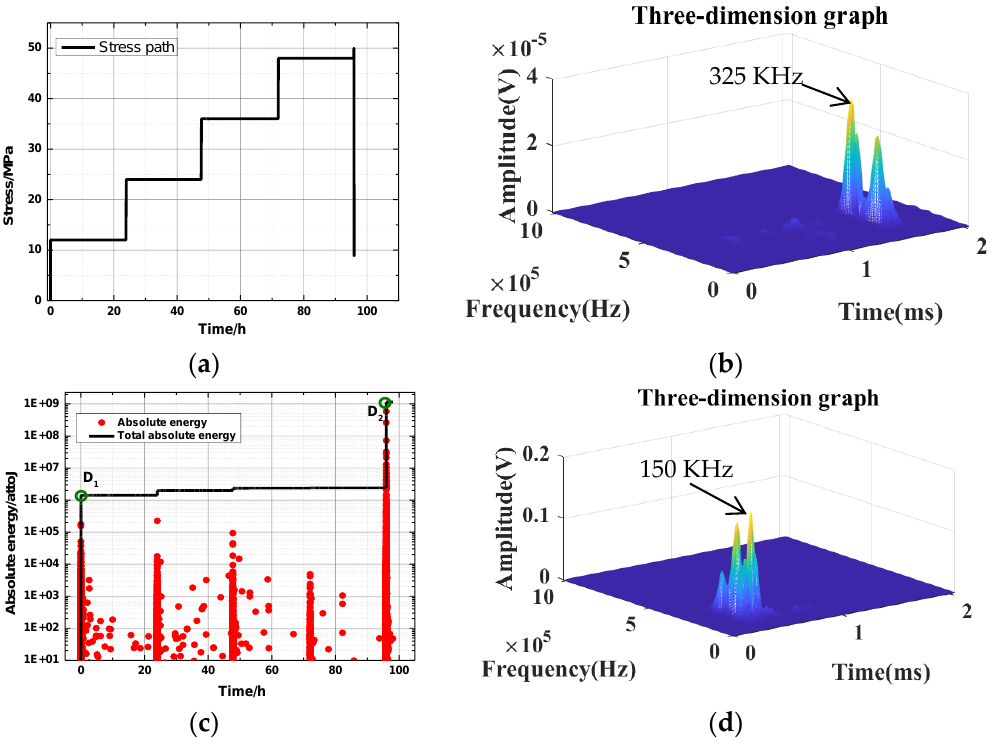
Figure 12. Stress with time for a 45-degree bedding angle under the saturated state: ( a ) the actual stress path; and ( c ) the corresponding acoustic emission energy curve. Images ( b , d ) are the waveform characteristics of key points. Table 7. AE energy level for different bedding angles under dry state.